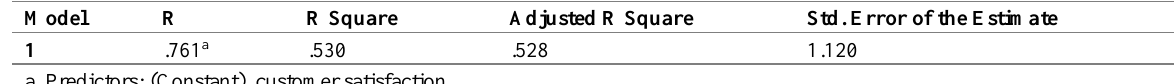
Table 3: The Model Summary of SMS Customer Service Platforms Effectiveness and Customer